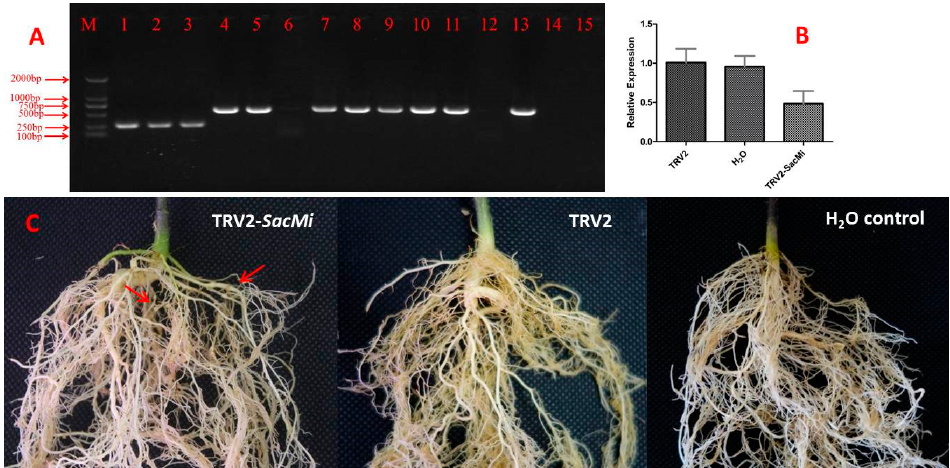
Figure 6. VIGS of SacMi increases the sensitivity to M. incognita in S. aculeatissimum . ( A ) PCR detection of TRV2- SacMi and TRV transcripts in vivo. M: Marker, 1–3: plants inoculated with TRV2; 4–13: plants inoculated with TRV2- SacMi ; 14–15: H 2 O control; ( B ) qRT-PCR analysis of SacMi mRNA transcript levels in SacMi -silenced plants, empty TRV2 vector control plants and H 2 O control plants; ( C ) Symptoms of TRV2- SacMi or TRV2 silenced or H 2 O control S. aculeatissimum plalnts infected by M. incognita at six weeks. Red arrows indicate developed root galls.